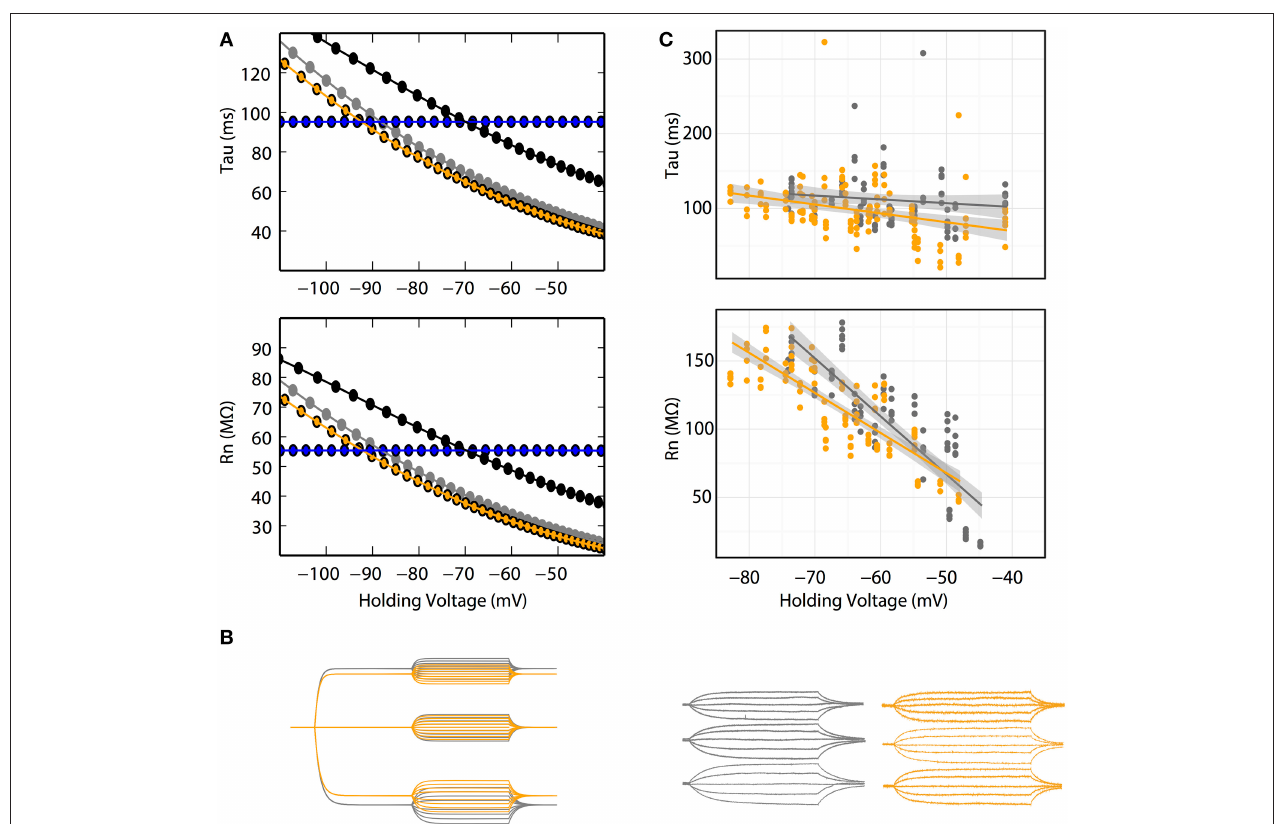
FIGURE 3 | (A) R n –voltage and tau-voltage relationships are concentration-dependent in the GHK model. Voltage dependence of R n and tau of 10 (gray) and 30 (orange) mM intracellular Cl − at fixed E rest ( − 85mV). Their corresponding K + and Cl − permeability ratios are 1.34 and 7, respectively. Black: voltage dependence of R n and tau of 30 intracellular Cl − at a K + /Cl − permeability ratio of 1.34. Ohmic simulation is shown in blue. Each data point was calculated using voltage traces from 15 pA current pulse injection. (B) Voltage responses to current pulses in cerebellar Purkinje neurons are consistent with the GHK model simulation. Left, GHK model simulation using a series of current pulses ( − 60 to + 60 pA at 15 pA interval recorded at − 30, 0, and + 30 pA holding currents) for 10 and 30mM intracellular Cl − . Right, voltage responses to current pulses ( − 30 to + 30 pA at 15 pA interval recorded at − 30, 0, and + 30 pA holding currents) in cerebellar Purkinje neuron. For both simulation and experimental data, gray and orange represent 10 and 30mM intracellular Cl − . Holding potentials for 10mM Cl − at − 30, 0, + 30pA are identical to values reported in Figure 2E ; the holding potentials for 30mM Cl − are − 68, − 65, and − 60mV, respectively. (C) R n –voltage and tau-voltage relationships are concentration-dependent in cerebellar Purkinje neurons. Comparisons of tau and R n values at each current pulse, between 10 and 30mM intracellular Cl − . 30mM Cl − reduced the steepness of the regression slope of R n -voltage ( β 10mM = − 5.6 , n > 6, β 30mM = − 2.9 , n = 6 , p = 0.0002